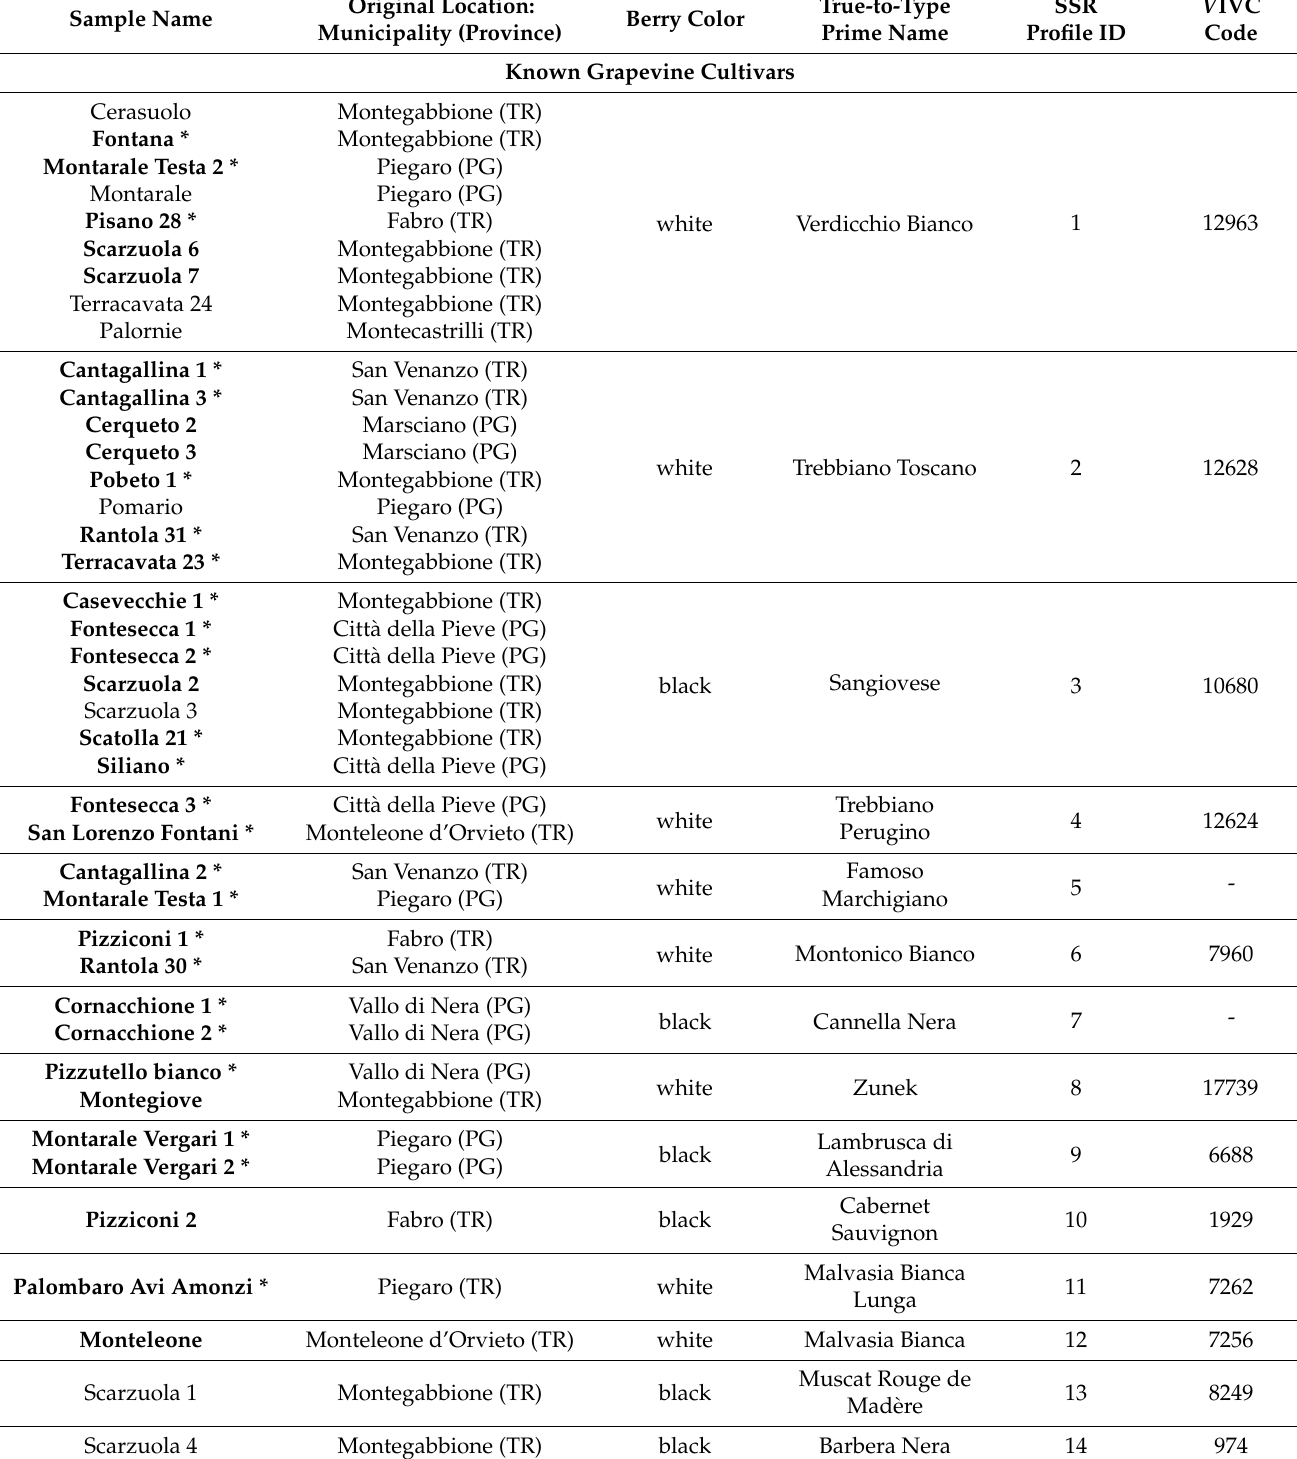
Table 1. List of the 70 grapevine samples grouped by their genotype. Original locations (municipality and province), berry color, true-to-type prime name, SSR profile ID number, and Vitis International Variety Catalogue [11] code are reported. In brackets: Italian common synonyms of some grapevine cultivars, according to the Italian Catalogue of Grapevine Varieties